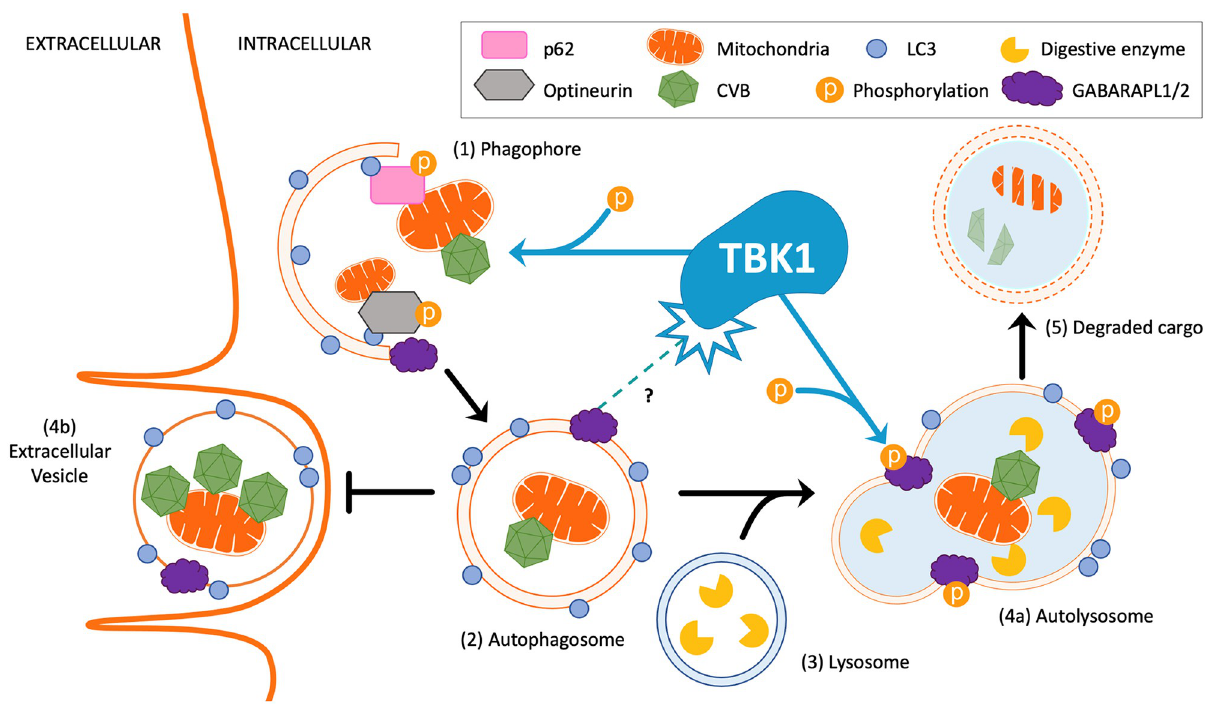
Fig 10. Hypothetical model of TBK1 function and CVB infection. CVB has previously been shown to rely on autophagy to promote viral replication. Here, we describe the anti-viral role of the phosphor-kinase TBK1 in autophagic elimination of CVB. (1) Phagophore initiation is by the recruitment and assembly of autophagic machinery. Among the key machinery components, ATG8 family members including LC3, GABARAPL1, and GABARAPL2 regulate phagophore elongation. ATG8 proteins coordinate cargo selection (such as damaged mitochondria and pathogens like CVB) with autophagy adaptors, p62 and Optineurin. TBK1 is known to directly phosphorylate p62 and Optineurin for efficient cargo selection. (2) Upon closure of the phagophore, the autophagosome is formed and fuses with the (3) lysosome to form the autolysosome. Here, TBK1 phosphorylates LC3 and GABARAPL2 to inhibit premature shedding of the autophagosome and promote flux. (4a) Upon fusion, the inner membrane space of the autolysosome undergoes acidification and digestive enzymes are activated to (5) degrade its contents. (4b) However, in the absence of TBK1, the autophagosome subverts fusion with the lysosomes and is released from the intracellular space to the extracellular space as an extracellular vesicle (EV) containing infectious CVB and mitochondrial